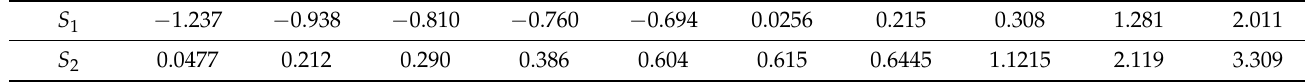
Table 1. Data used in the first example.